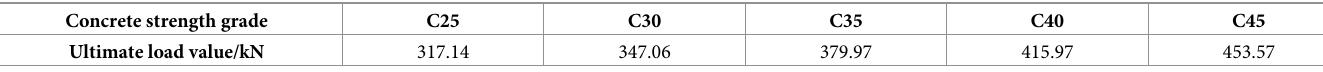
Table 15. Ultimate load values of reinforcement parts with different diameter of SMA